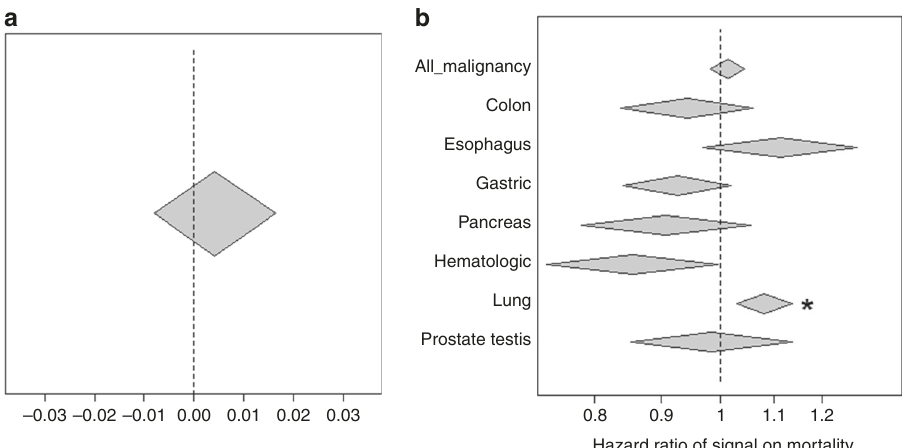
Fig. 4 Inference of clinical signi fi cance of mLOY. a Associations between overall mortality and signals of mLOY. b Associations between signals of mLOY and mortality due to malignancy and organ-speci fi c malignancy. Signals of mLOY are multiplied by − 1 of normalized LRR (the lower LRR indicating large fraction of mLOY, the higher signals are). Thus, beta exceeding 0 and hazard ratio exceeding 1 indicate associations between poor outcome (increased mortality) and lower intensity (more mosaic). Width of diamonds indicates 95% con fi dence interval. All results are obtained in Cox proportional hazard models. *indicates signi fi cant associations beyond Bonferroni ’ s